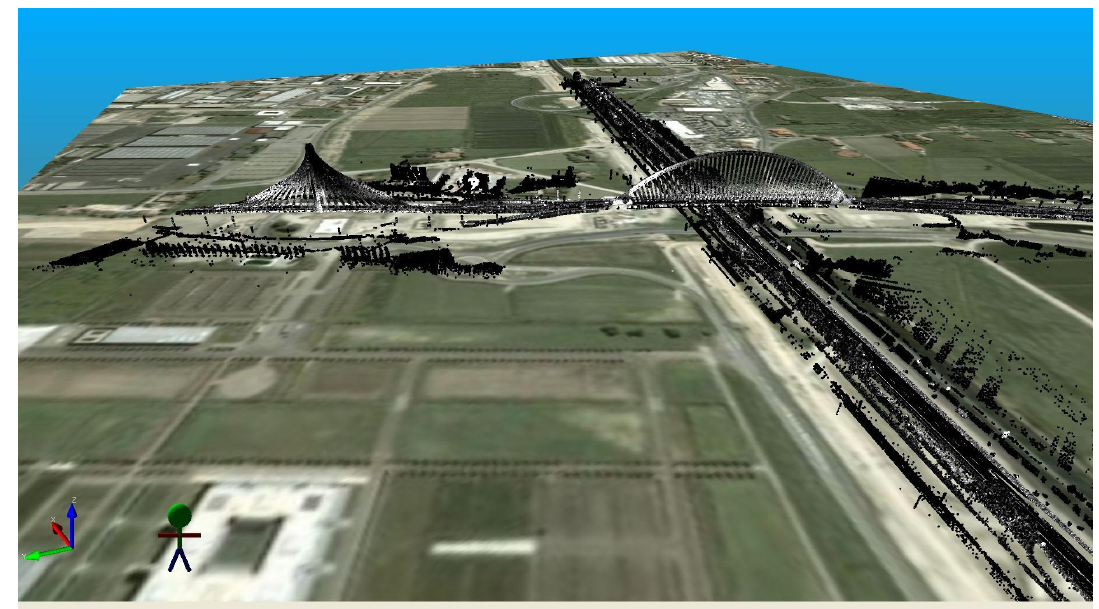
Figure 4 – Point cloud of Calatrava